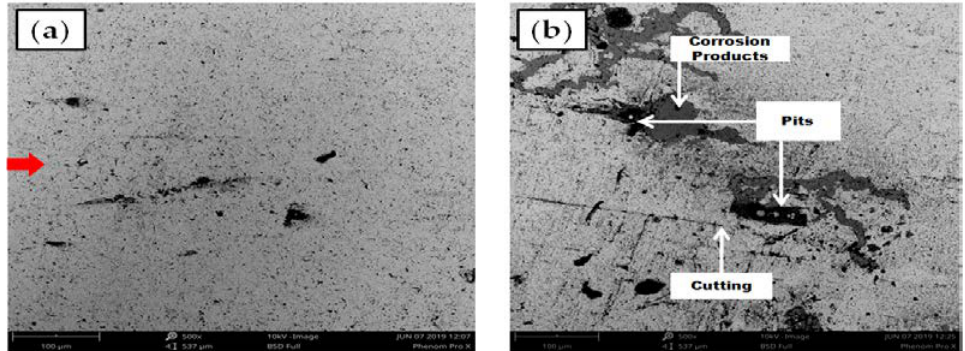
Figure 17. Microscopic images of 90-degree elbow BH section after the test at 1 m/s flow velocity ( a ) inlet ( b ) outlet.